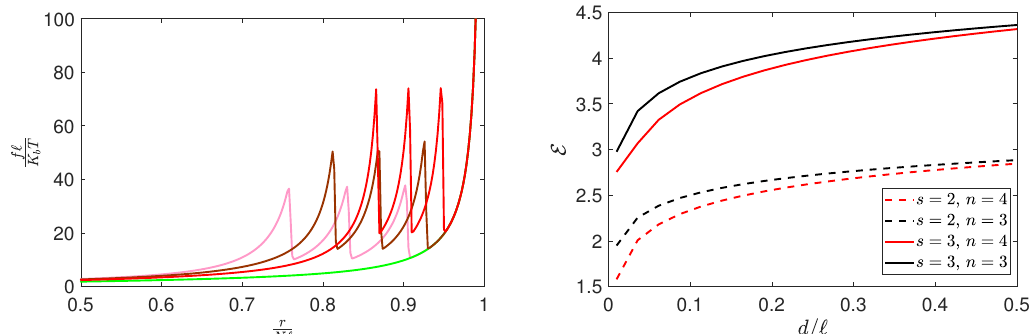
Figure 11. Helmholtz force–extension response (left panel) and extra-toughness (right panel) for a chain with different s and n and varying d / (cid:96) . We also added the response of the same system without sacrificial bonds in order to compare the different behaviors (green curve). On the left panel, we considered a chain with s = 3, n = 4 and d / (cid:96) = 1/10,3/10,1/2 (pink, brown, and red curves, respectively). On the right panel, the extra-toughness is calculated for n = 3,4, s = 2,3 and 1/100 < d / (cid:96) < 1/2. The plots are represented with adimensional quantities. The other parameters are given by N = 50, h / k = 1, and E / ( K b T ) = 75.